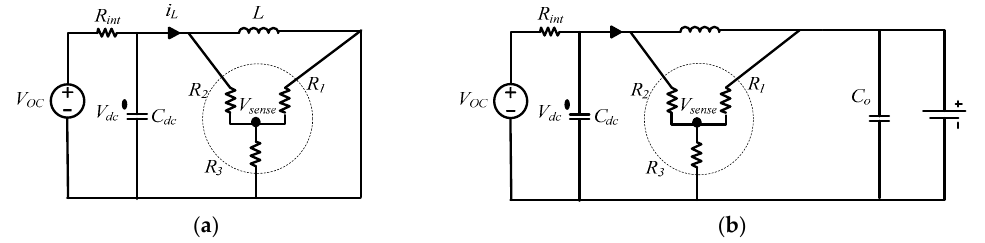
Figure 6. Equivalent circuit of the converter during ( a ) ON time ( b ) OFF time.